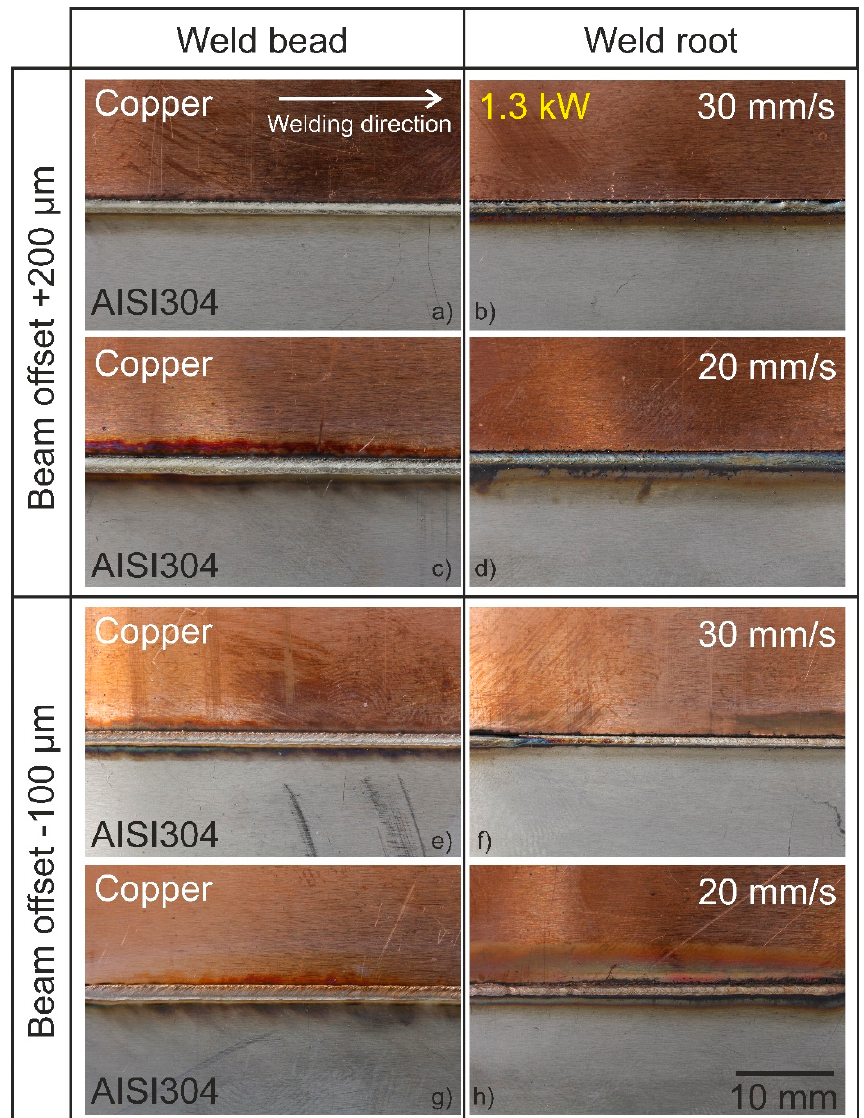
Figure 2. Weld bead and root appearance for joints produced with laser power of 1.3 kW, ( a ) weld bead and ( b ) weld root of weld No. 2, ( c ) weld bead and ( d ) weld root of weld No. 3, ( e ) weld bead and ( f ) weld root of weld No. 4, ( g ) weld bead and ( h ) weld root of weld No. 8. Table 6. Measured width for dissimilar metal-welded joints.